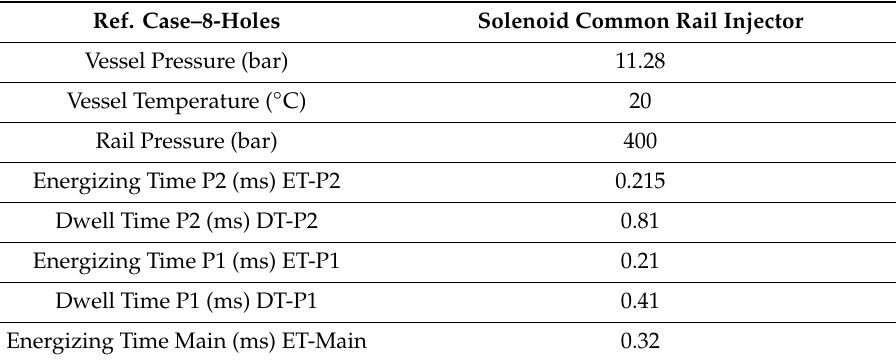
Table 3. Main characteristics of the reference injection